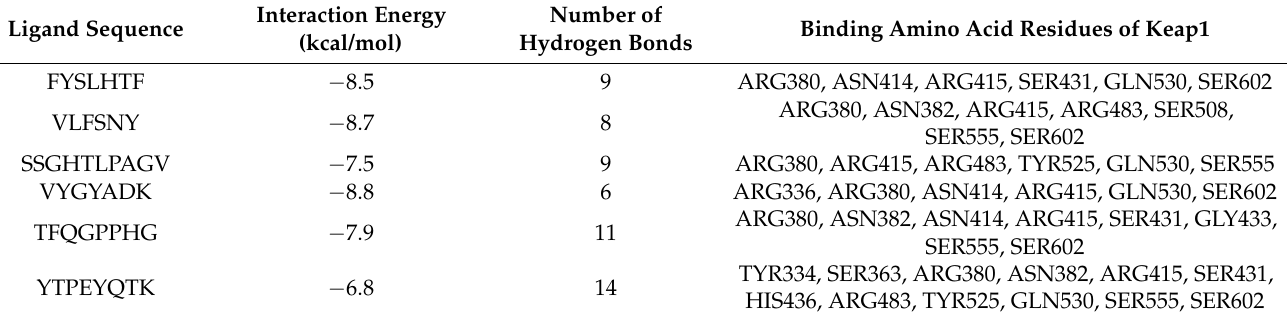
Table 2. Molecular docking results of identified peptides from Chinese pecan with